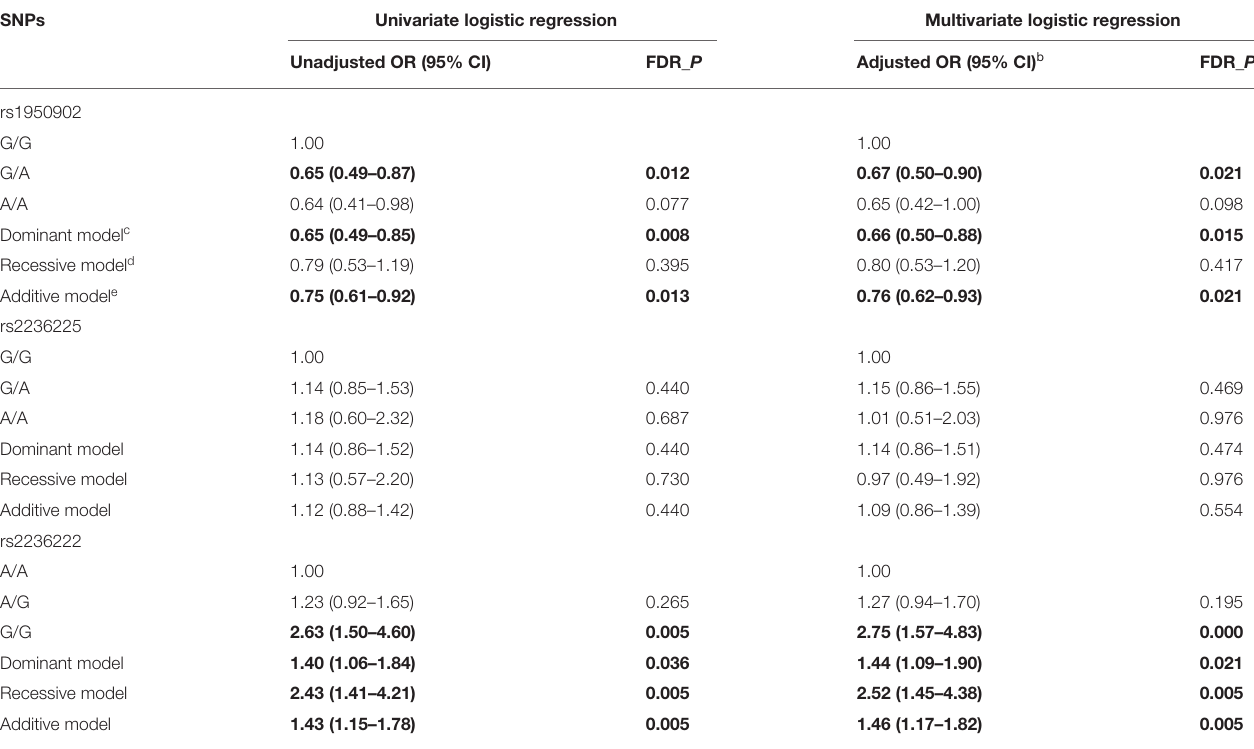
TABLE 4 | Associations between maternal polymorphisms of MTHFD1 gene and the risk of VSD. SNPs Univariate logistic regression Multivariate logistic regression Unadjusted OR (95% CI) FDR_